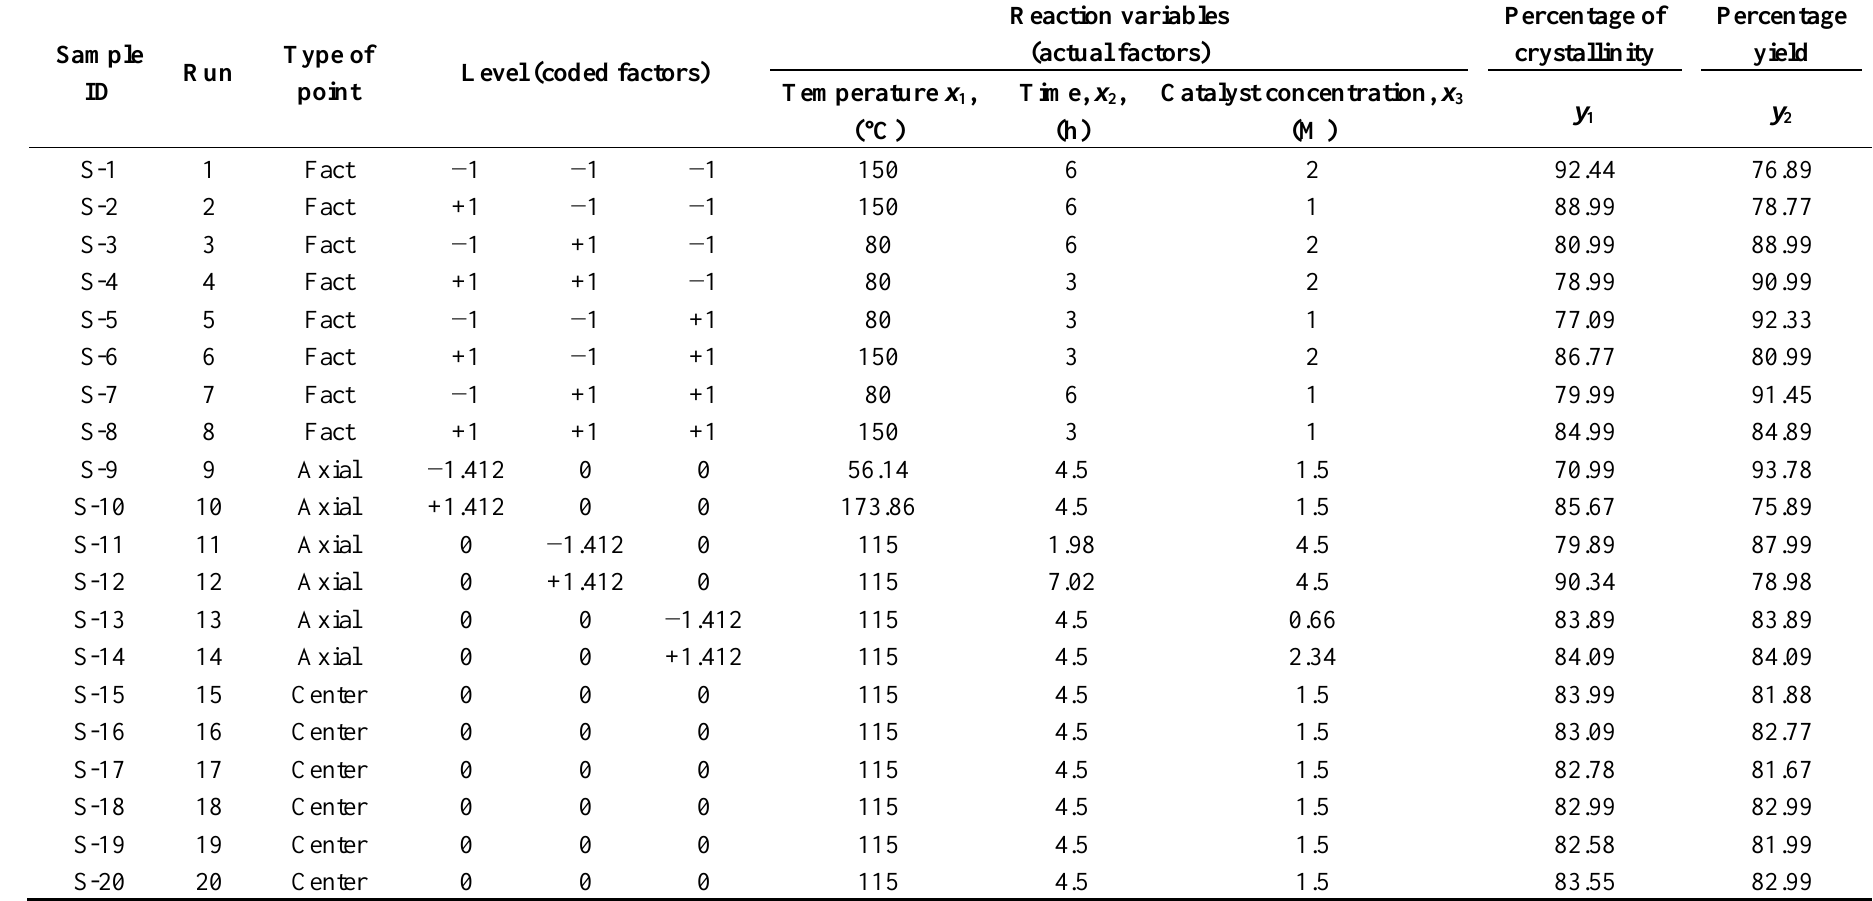
Table 5. Experimental design matrix for acid hydrolysis of microcrystalline cellulose (MCC) in the presence of FeCl 3